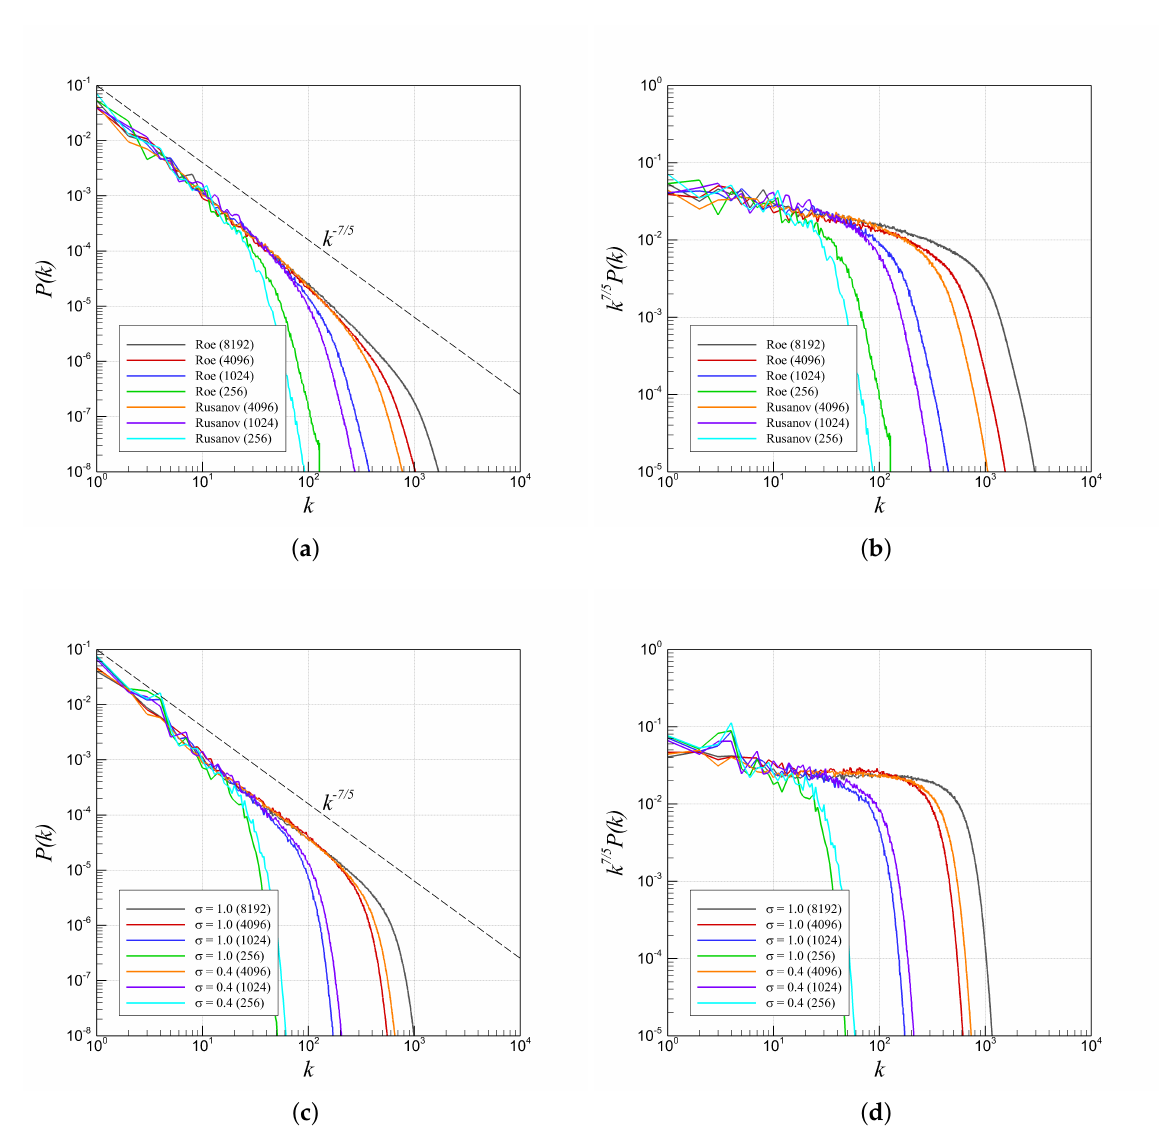
Figure 25. Comparison of ILES (ILES-Roe and ILES-Rusanov) models and CS+RF ( σ = 1.0 and σ = 0.4) models at different resolutions for the RTI problem with single-mode perturbation showing the power density spectra and compensated power density spectra; ( a ) power density spectra using ILES solvers; ( b ) compensated power density spectra using ILES solvers; ( c ) power density spectra using CS+RF solvers; ( d ) compensated power density spectra using CS+RF